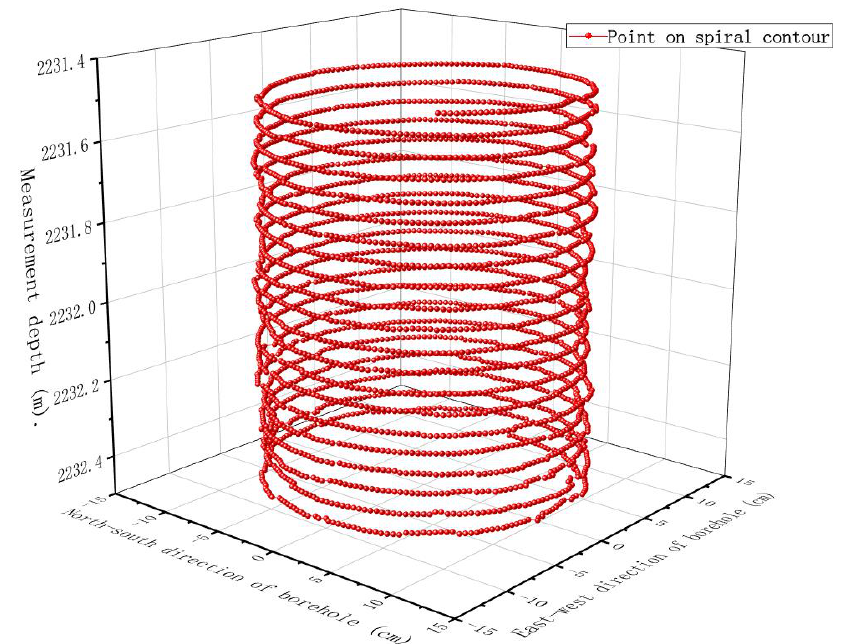
vertical direction of the wellbore, the X-axis represents the north – south direction displace- ment of the wellbore, and the Y-axis represents the east – west displacement of the well- Figure 12. Wellbore formed by uniform contour lines obtained after processing. Figure 12. Wellbore formed by uniform contour lines obtained after processing. bore, which follows the typical convention used in the oil industry. The structure after treatment is shown in Figure 13a,b. According to the rules of spiral wellbore surface reconstruction, four adjacent spatial points were connected to form the inner surface structure of the wellbore, forming a relatively smooth surface (Figure 13a). The quadrilateral can be divided into two triangles by adding a diagonal line to each par- allelogram in the clockwise direction of the drilling rotation (Figure 13b). Figure 13 was established based on a Cartesian coordinate system, in which the Z-axis represents the